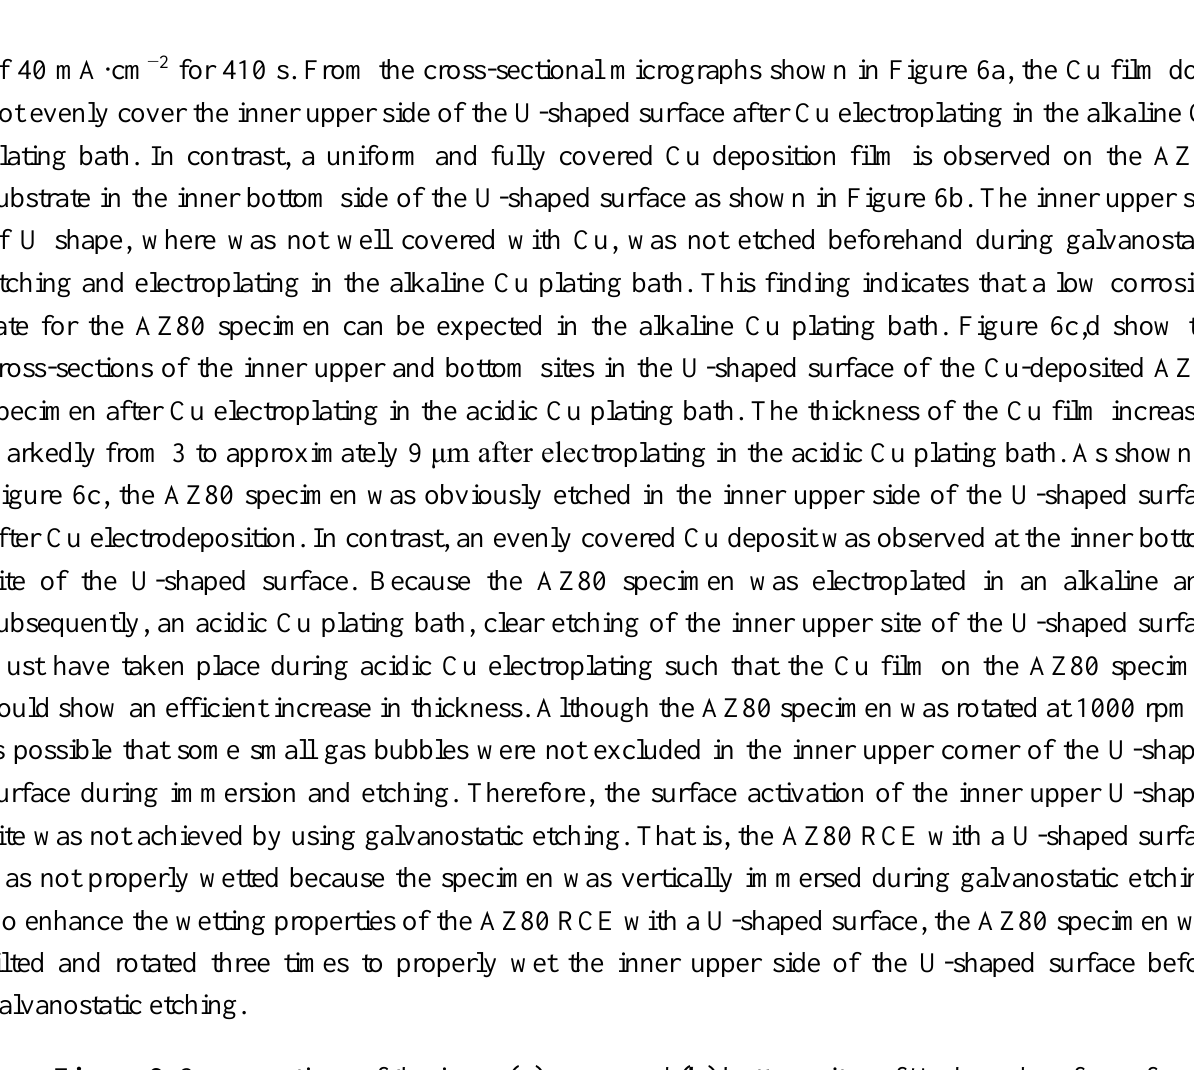
Figure 6. Cross sections of the inner ( a ) upper and ( b ) bottom sites of U-shaped surface of AZ80 specimen after galvanostatic etching followed by Cu electroplating in the alkaline Cu-plating bath and ( c ) and ( d ) the corresponding sites for the specimen after electroplating in an acidic Cu plating